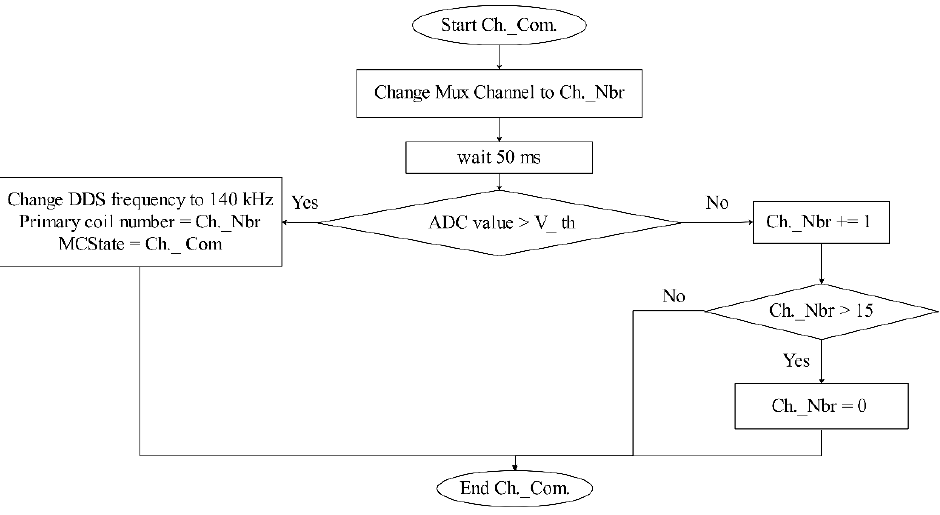
Figure 8. Scanning phase sub-algorithm flowchart.